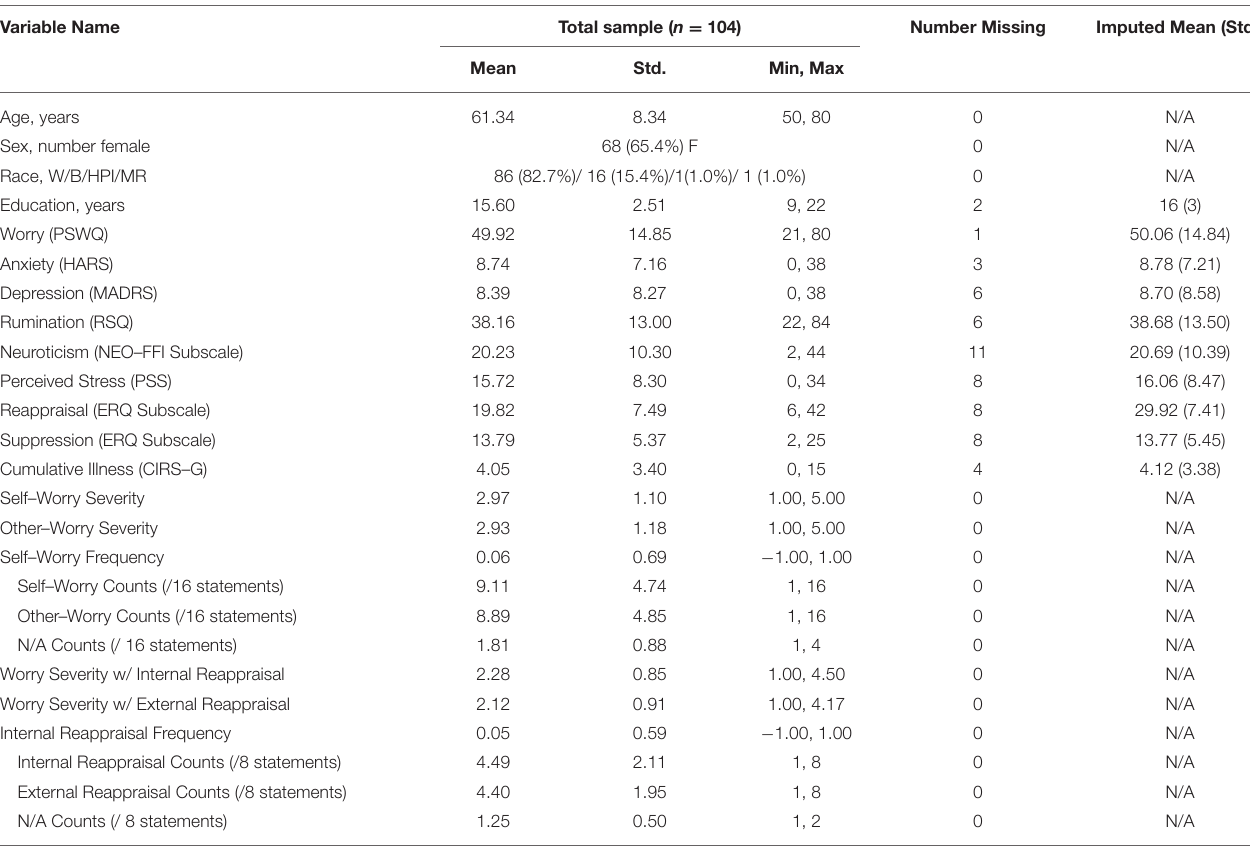
TABLE 1 | Characteristics of the